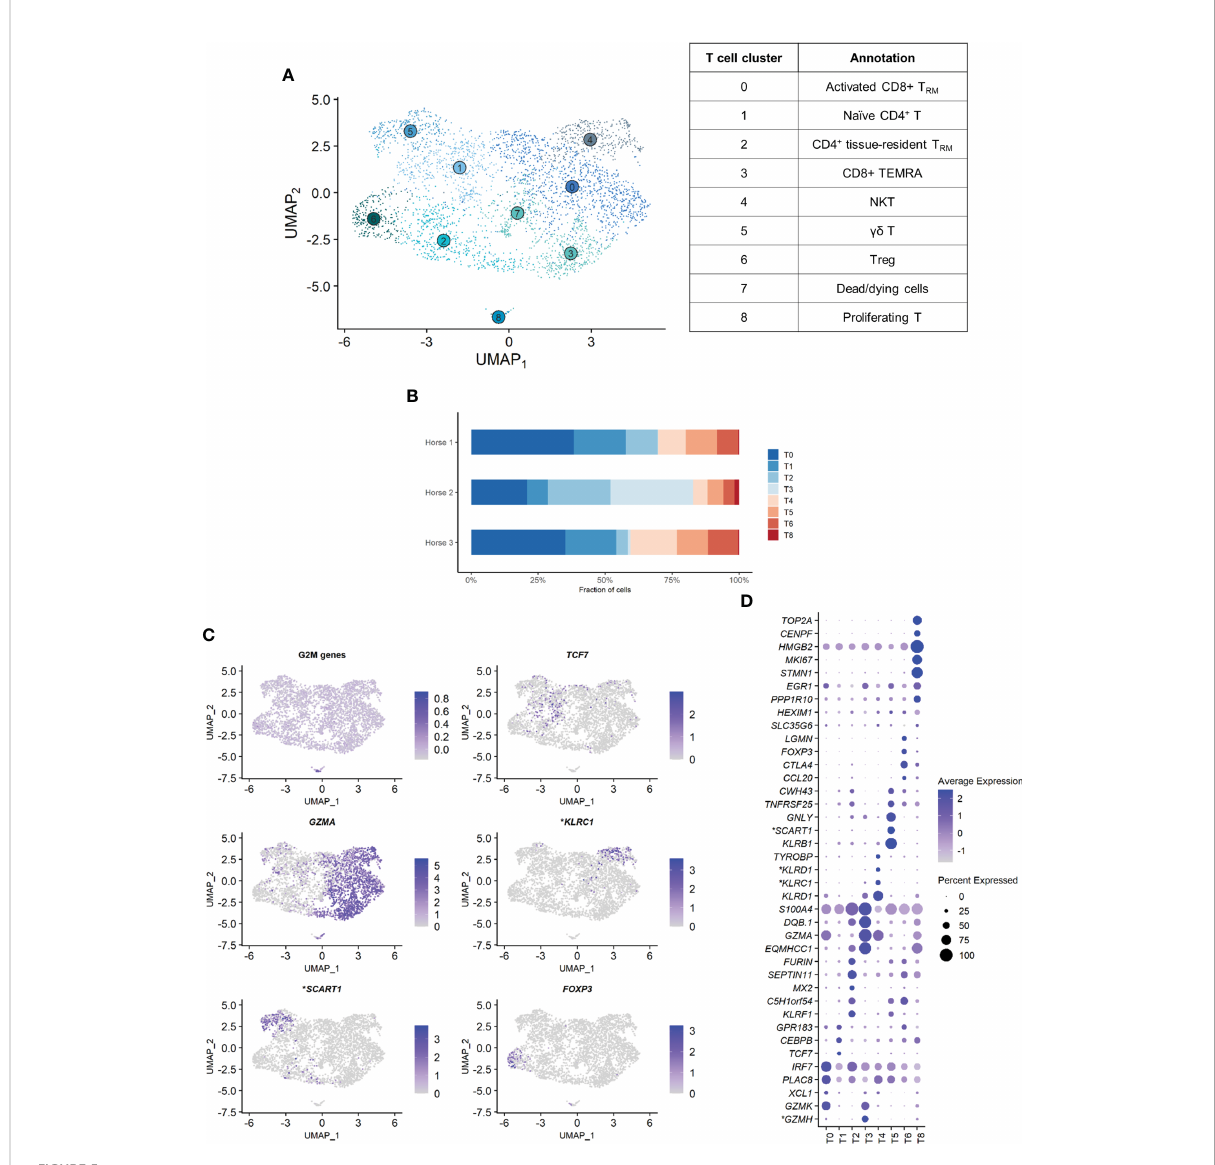
FIGURE 5 Independent analysis of the T cell population (n=3,465 cells) (A) UMAP visualization of the 9 T cell clusters identi fi ed, with suggested cluster annotation. T RM, tissue-resident memory. (B) Distribution of the T cell clusters for each horse, based on scRNA-seq analysis. (C) Gene expression patterns used for cell subtype assignment. *LOC100062846 annotated as killer cell lectin like receptor C1 (KLRC1), LOC100066851 as scavenger receptor family member expressed on T cells 1 (SCART1) (NCBI EqCab3.0 v103). (D) Dot plot of the 5 most upregulated genes in each cluster (one ribosomal RNA gene and two ribosomal protein genes removed). Dot size is proportional to the percentage of cells expressing the gene. Dot color intensity represents average gene expression. T7 (dead cells) is excluded. *LOC100066851 annotated as SCART1, LOC101910264 as killer cell lectin like receptor D1 (KLRD1), both LOC100062823 and LOC100062846 as KLRC1, both LOC100051986 and LOC100147522 as granzyme H (GZMH) (NCBI EqCab3.0